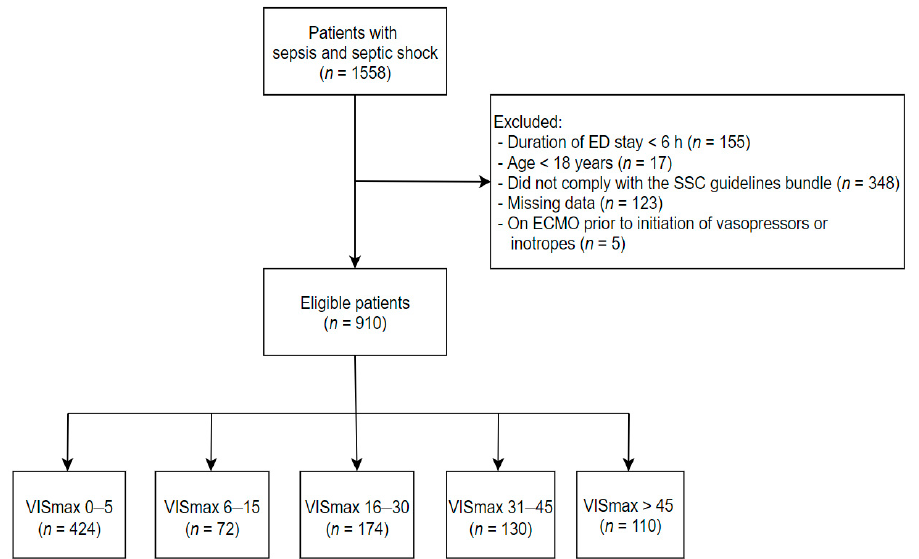
Figure 1. Flowchart of the study population. ED: emergency department; SSC: Surviving Sepsis Campaign; ECMO: extracorporeal membrane oxygenation; VIS: vasoactive-inotropic score.